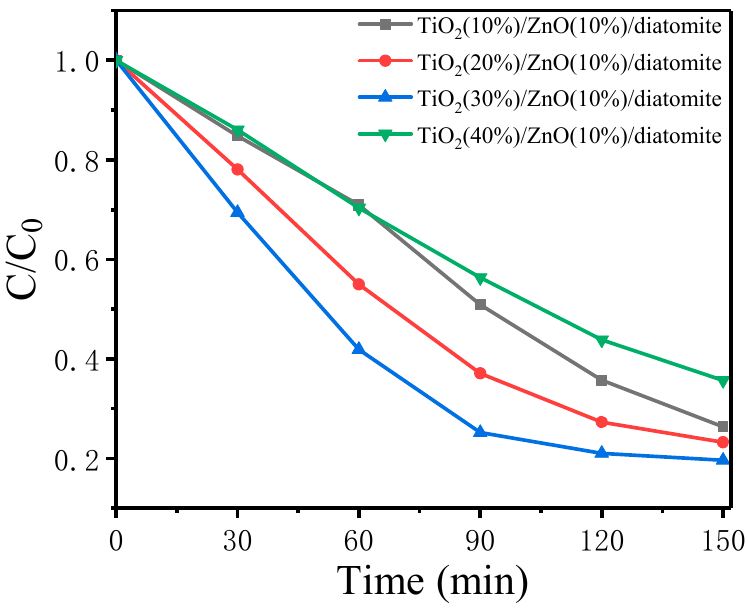
Figure 8. MB photodegradation of various catalysts under visible light.